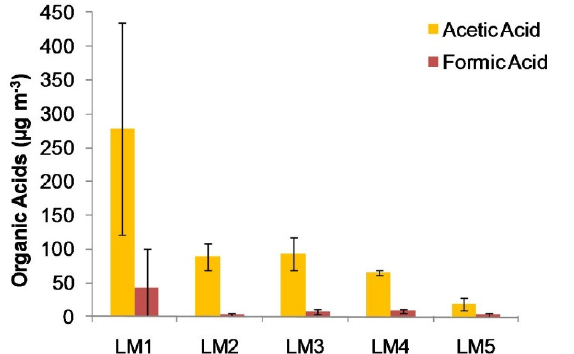
Fig. 5. Organic acids (acetic and formic acids) concentration measured in the LTMCM. Values represent the average from two parallel samplers. For abbreviations and location character- istics see Table